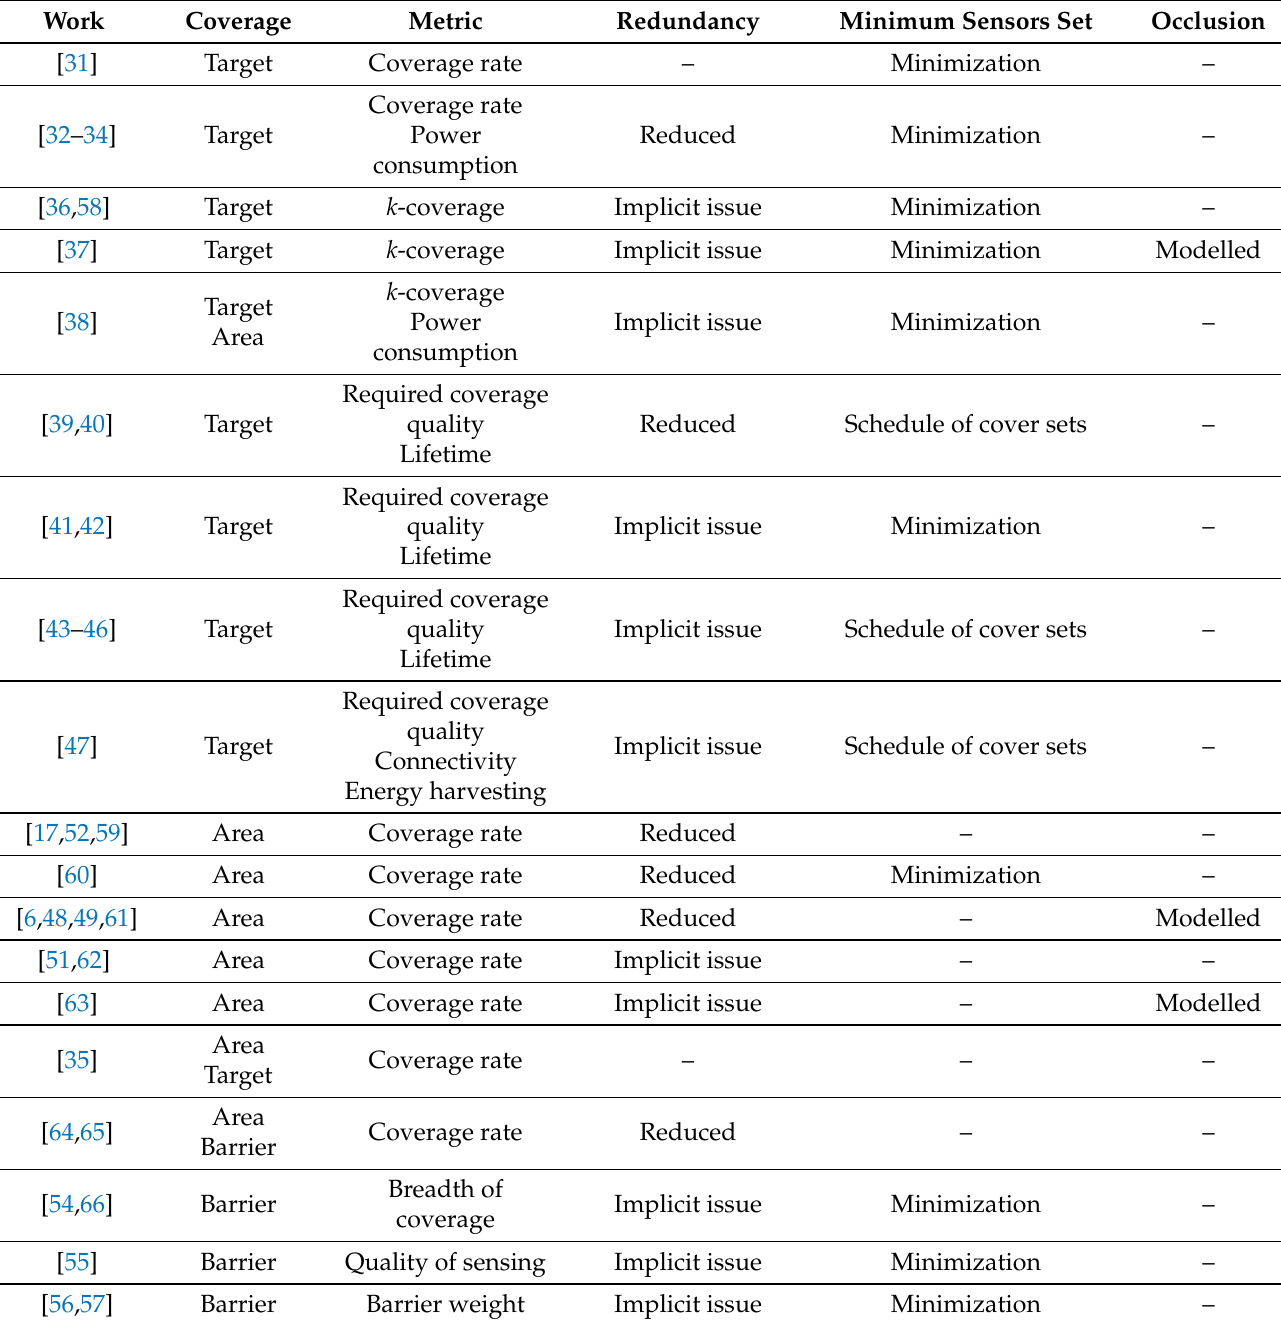
Table 1. Summary of the performed spatial coverage quality